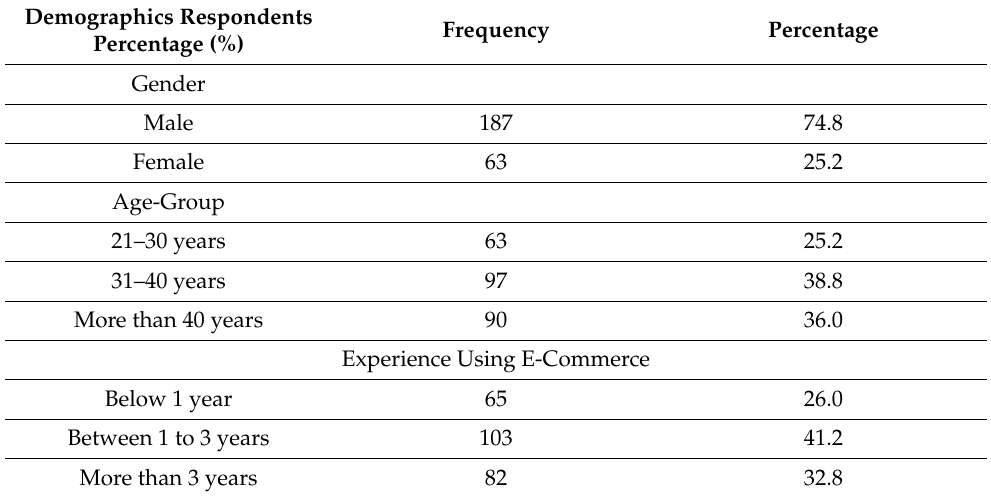
Table 2. Demographic analysis.